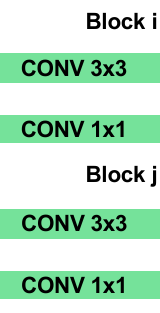
Figure 7. Bottleneck approach.